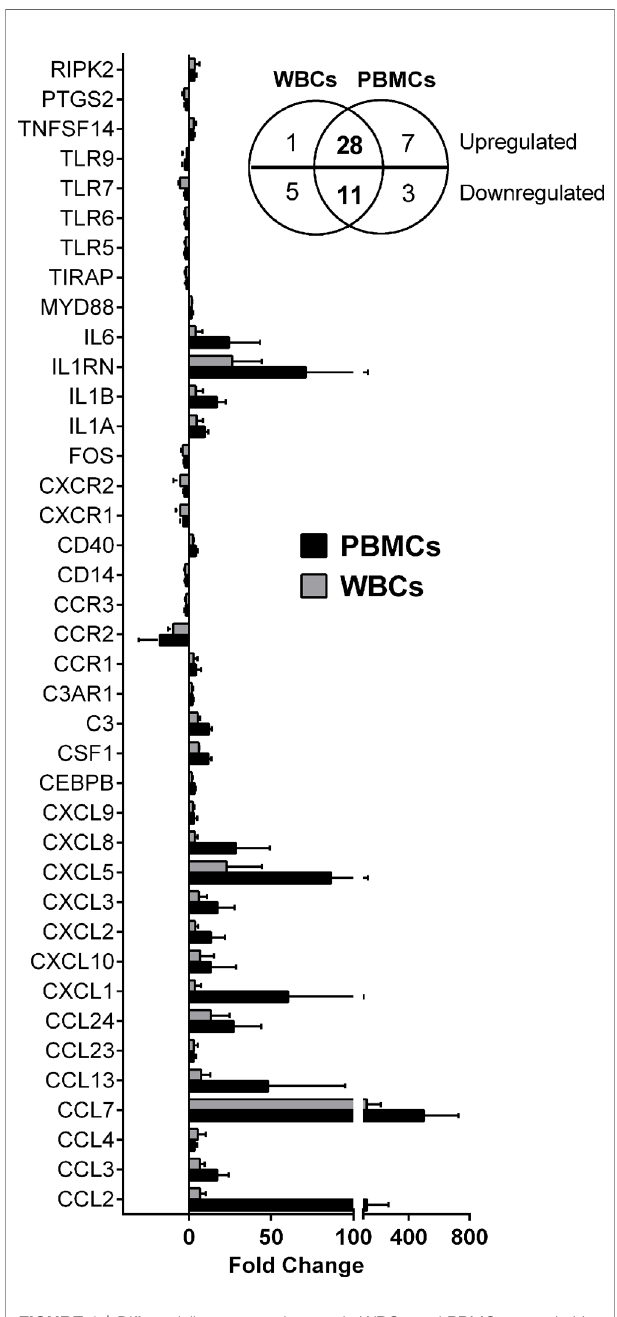
FIGURE 1 | Differentially expressed genes in WBCs and PBMCs upon L. V. panamensis infection. Fold change gene expression (infected vs. uninfected) of genes modulated in WBCs and PBMCs from three healthy donors after ex vivo infection with L. V. panamensis for 24h. Insert: Venn diagram representing the number of upregulated and downregulated